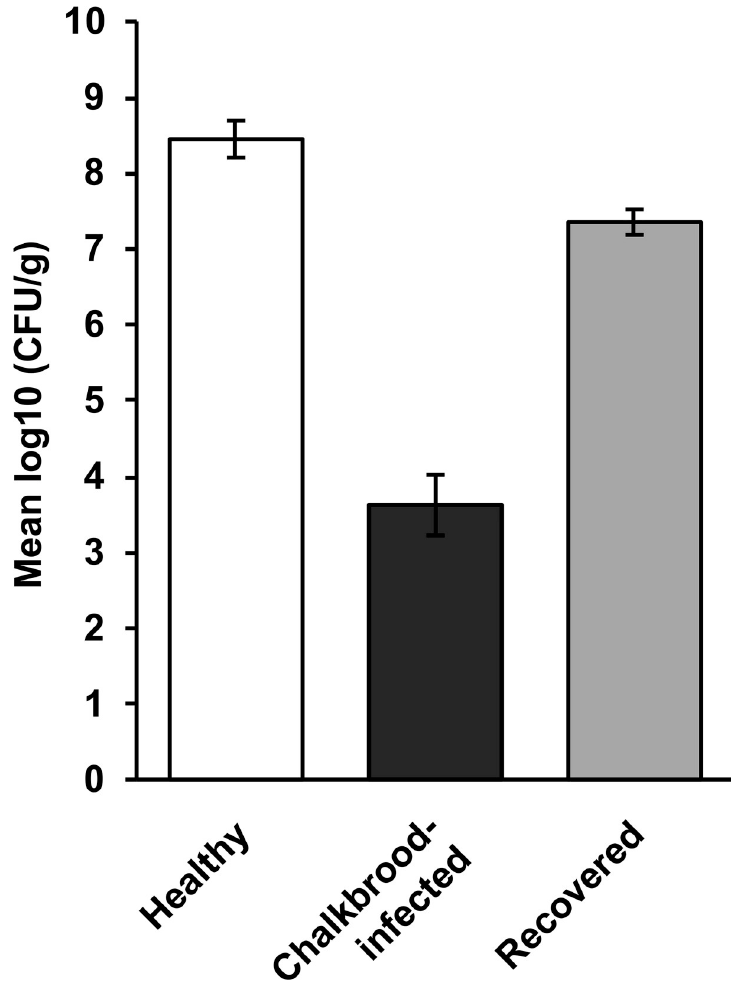
Fig 3. Aerobic gut bacterial numbers (CFU/g) in nurse bees from healthy hives ( n = 10), chalkbrood-infected hives (n = 10), and chalkbrood-infected hives 21 weeks after the disappearance of disease signs (recovered; n = 10). All bees were collected from a single apiary in New South Wales. The differences between all groups are statistically significant ( P < 0.001). Error bars represent the SEM with a 5% least significant difference (LSD) level of 1.095.